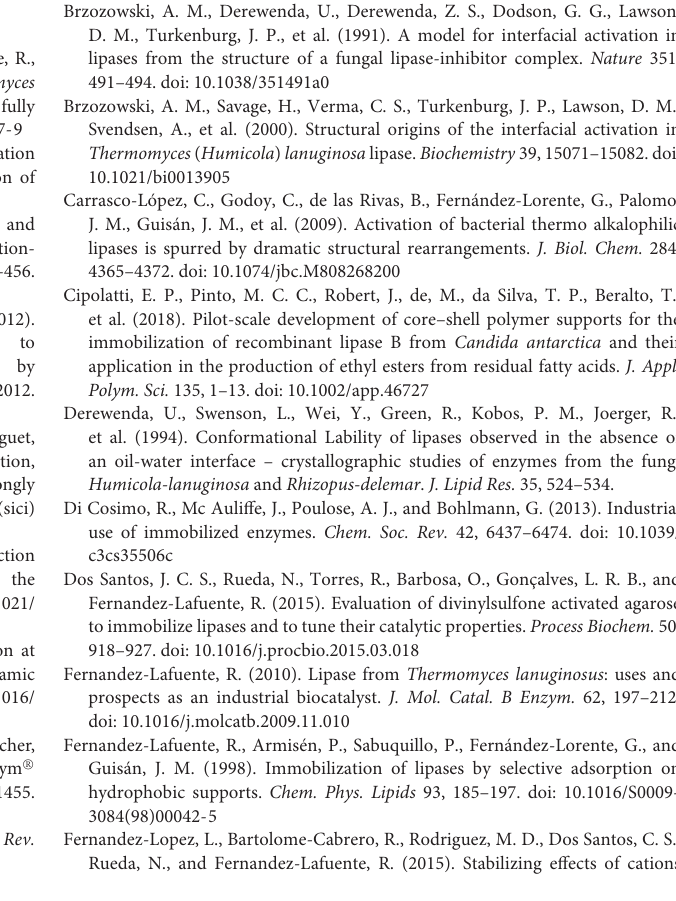
FIGURE S1 | Inactivation courses of low loaded PFL preparations (empty squares) and high loaded PFL preparations (solid squares). The low loaded PFL preparations (1 mg/g) were inactivated at 70 ◦ C, pH 7.0 and high loaded PFL preparations (60 mg/g) were inactivated at 75 ◦ C, pH 7.0. Immobilization conditions: (A) 5 mM of Tris HCl buffer at pH 7.0. (B) 100 mM of sodium phosphate buffer at pH 7.0. (C) 5 mM of Tris HCl buffer with 10 mM CaCl 2